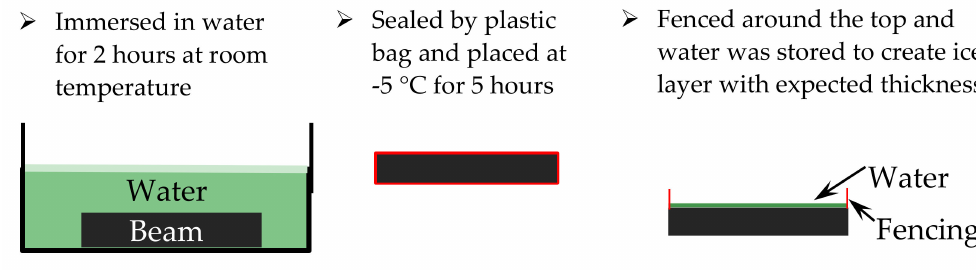
Figure 3. Process of prepare ice layer with certain thickness on